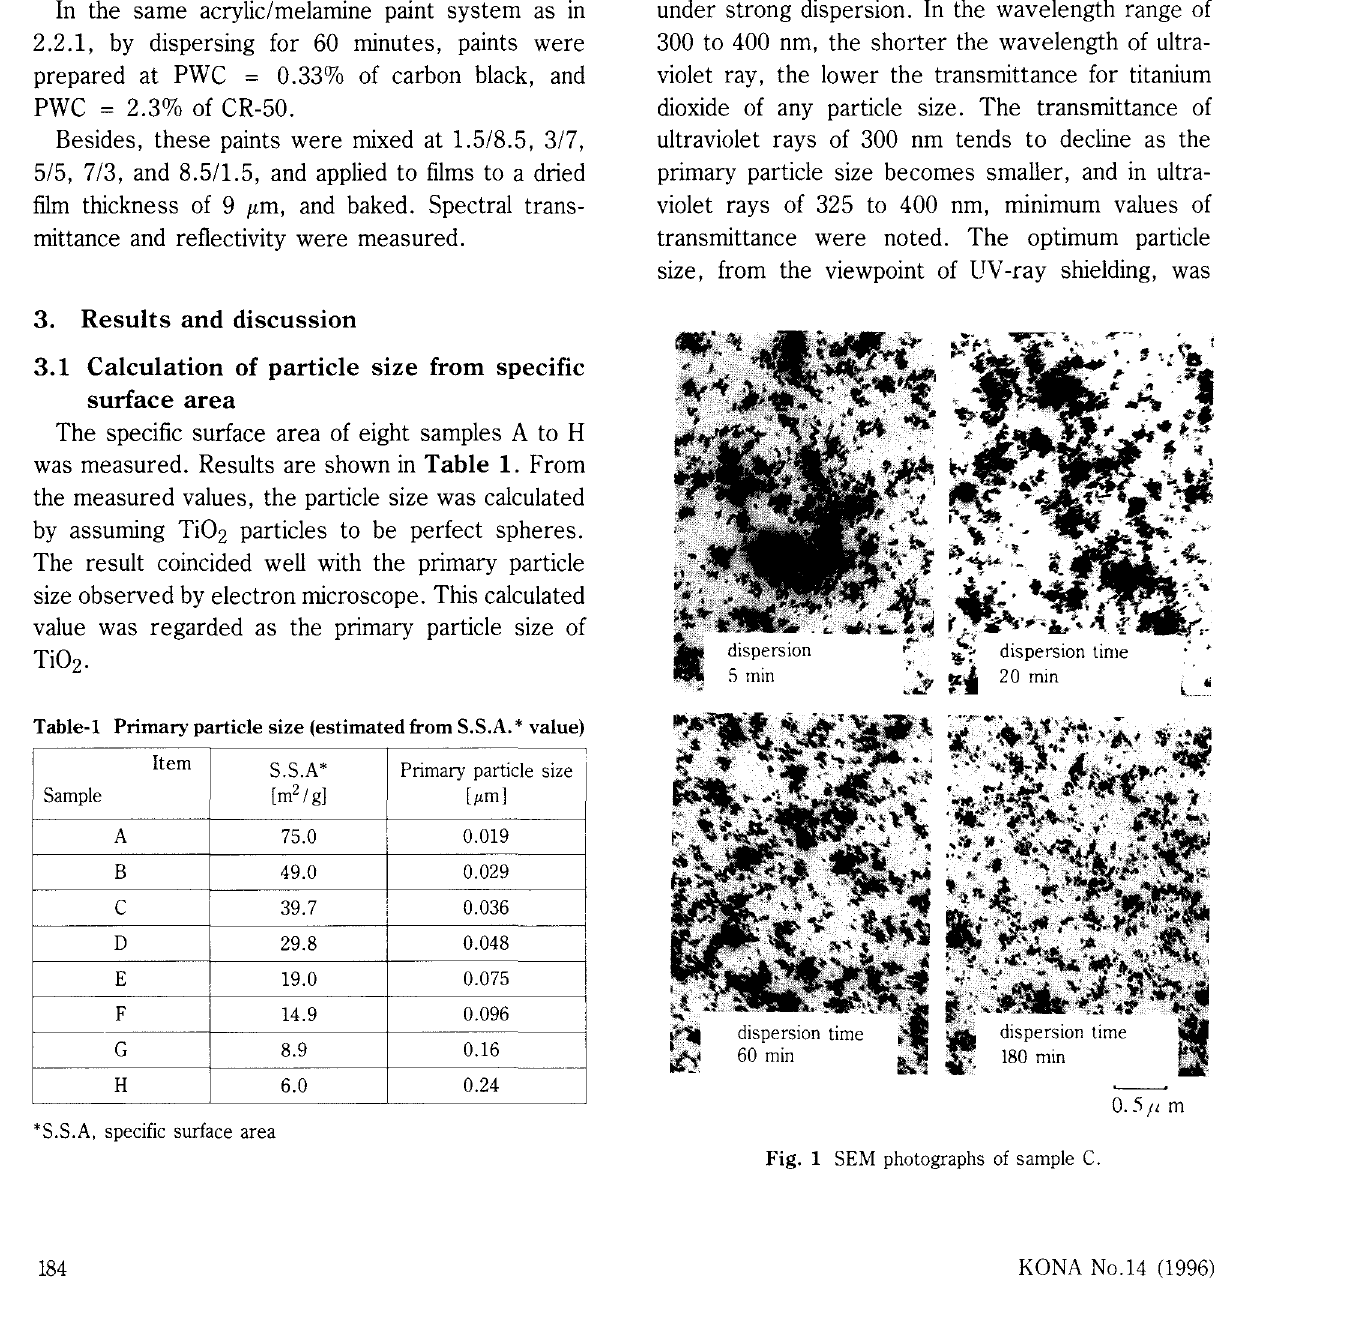
Fig. 1 SEM photographs of sample